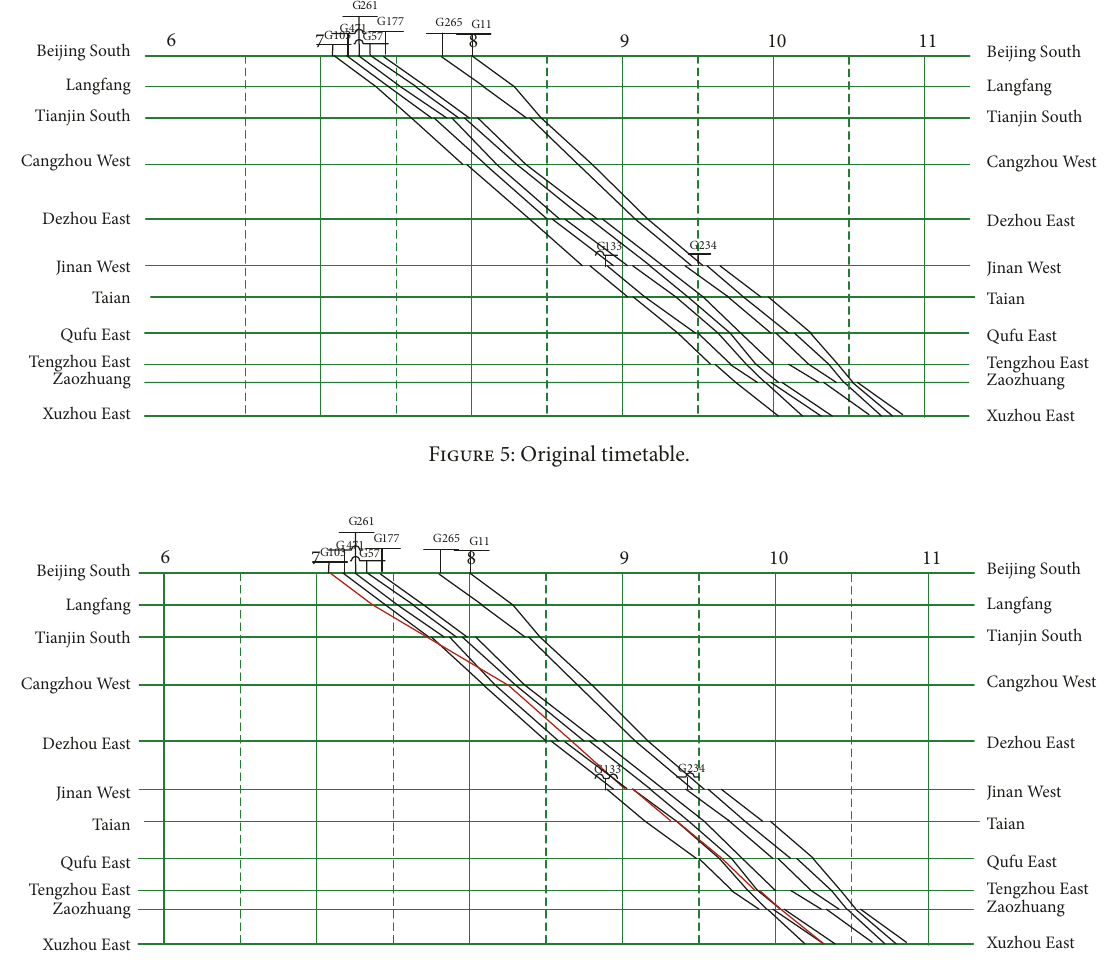
Figure 6: Timetable after delay.